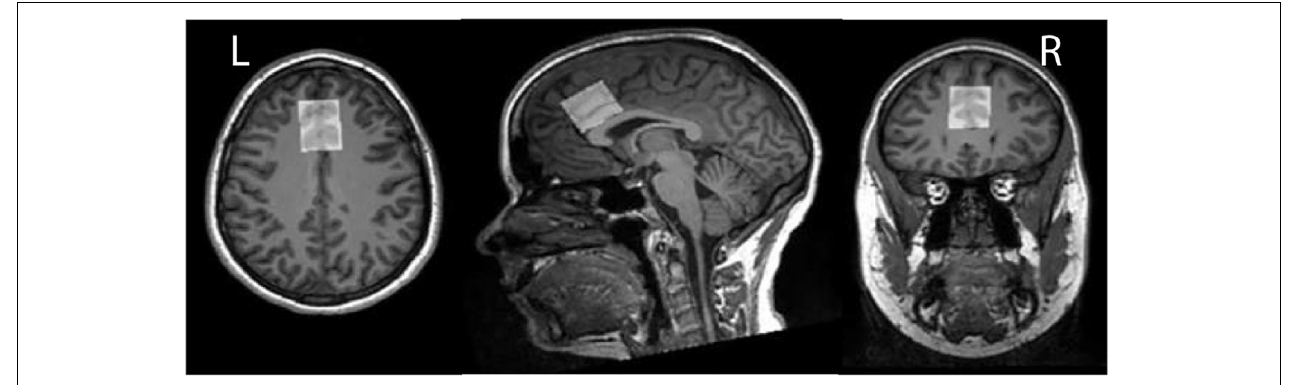
FIGURE 2 | In vivo GSH- and GABA+-edited spectra were acquired from dorsal anterior cingulate cortex (dACC) voxel (30 mm × 25 mm × 25 mm). Here we depict the dACC voxel placement for a single exemplar